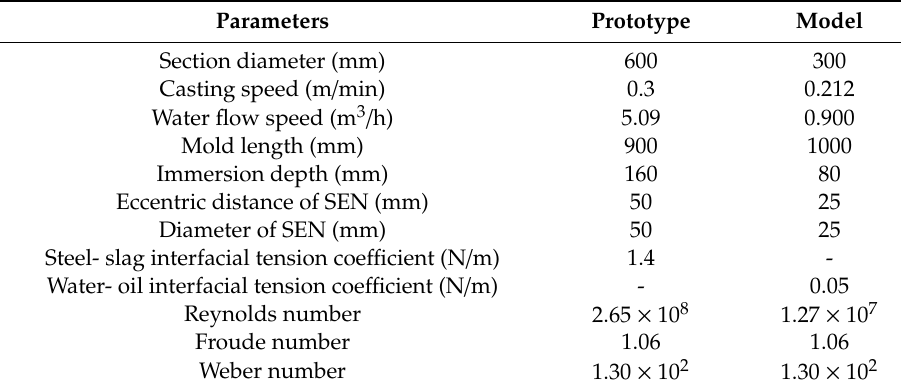
Figure 3. Water modeling experiment schematic. (1) Casting Tundish; (2), (5) slide gate; (3) Submerged nozzle; (4) Mold; (6) High speed camera; (7) DJ800 hydraulic acquisition treatment system. Table 4. Water model experiment parameters.